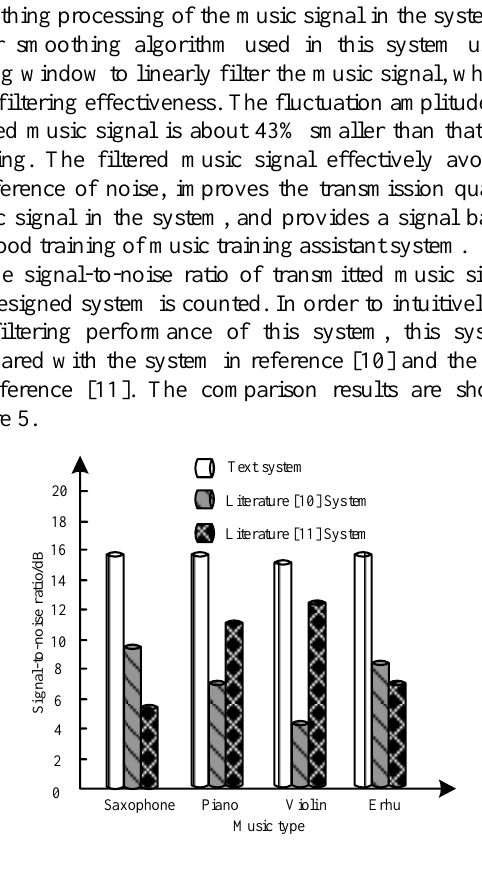
Figure 5. Comparison of signal-to-noise ratio of music signals in different